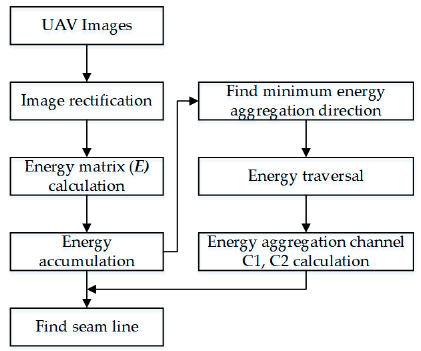
Figure 7. Three groups of experimental unmanned aerial vehicle (UAV) images. ( a ) The first image pair; ( b ) The second image pair; ( c ) The sequence images of a single-strip.